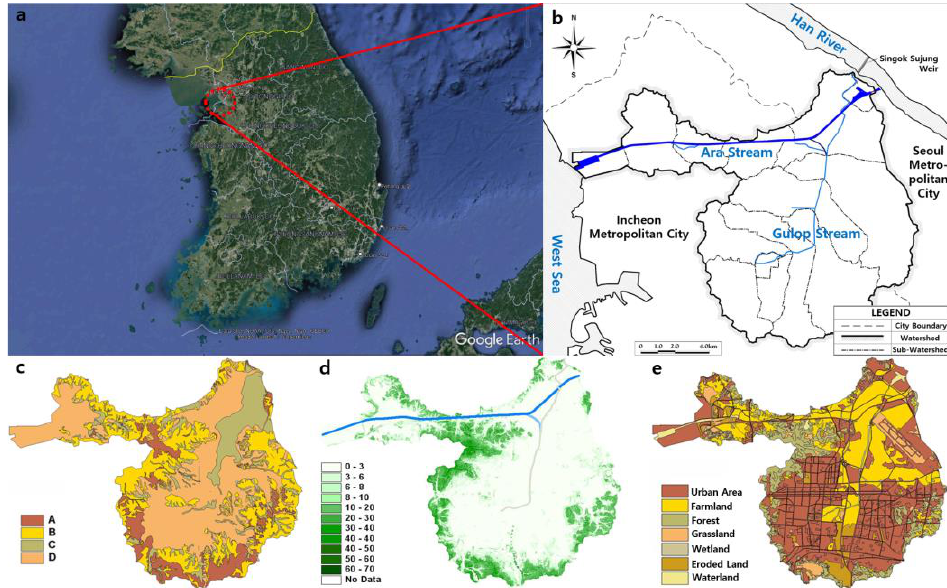
Figure 1. Gulpo and Ara Stream Location ( a , b ), Soil Map SCS Classification ( c ), Slope Distribution ( d ), Land Use ( e ).